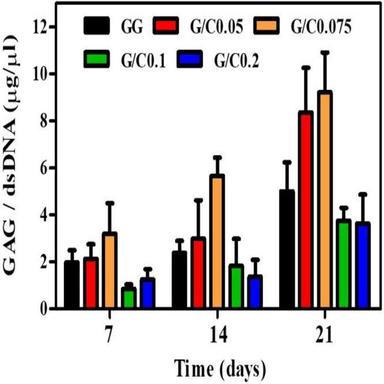
GAG quantitative analysis of chondrocytes encapsulated in the hydrogels (values are mean ± SD, n = 3).